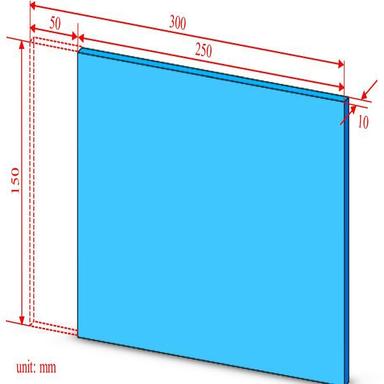
The dimensions of Kirchhoff plates, T < W=8 (T is the thickness of the plate and W is the width of the plate).